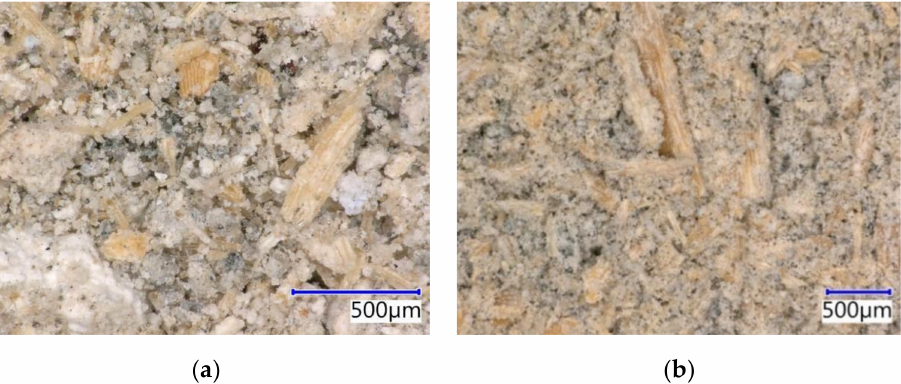
Figure 5. Alternative components (by-products) for modification of cement-bonded particleboard composition—images from Keyence VHX-950F optical microscope: ( a ) PM—particle mixture from cement-bonded particleboard production; ( b ) DU—dust from cutting of cement-bonded particle- boards during their formatting.